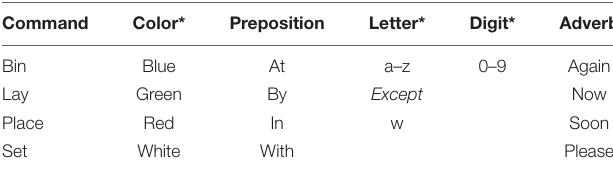
TABLE 1 | Structure of GRID corpus